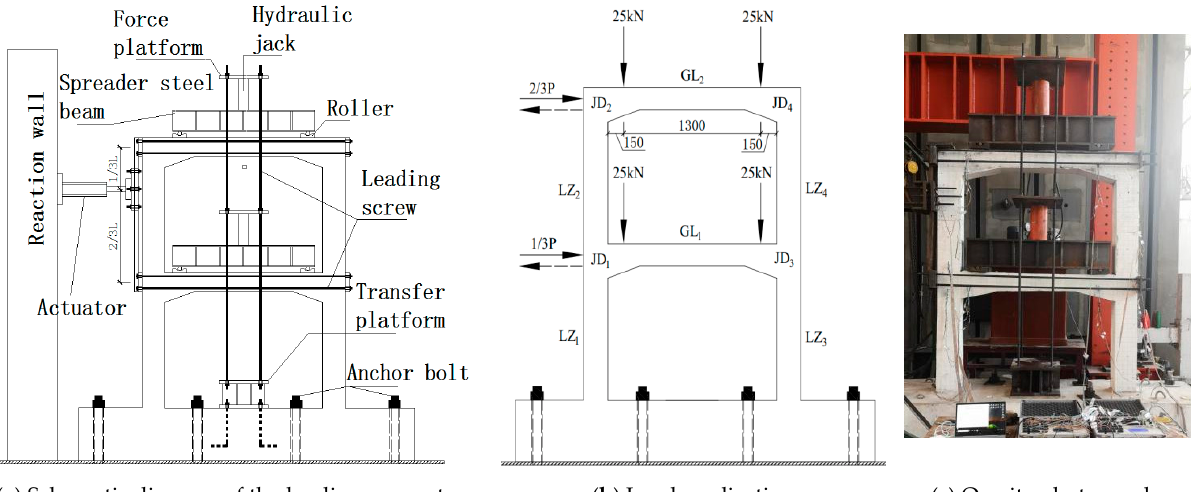
Figure 2. Loading device and scene.